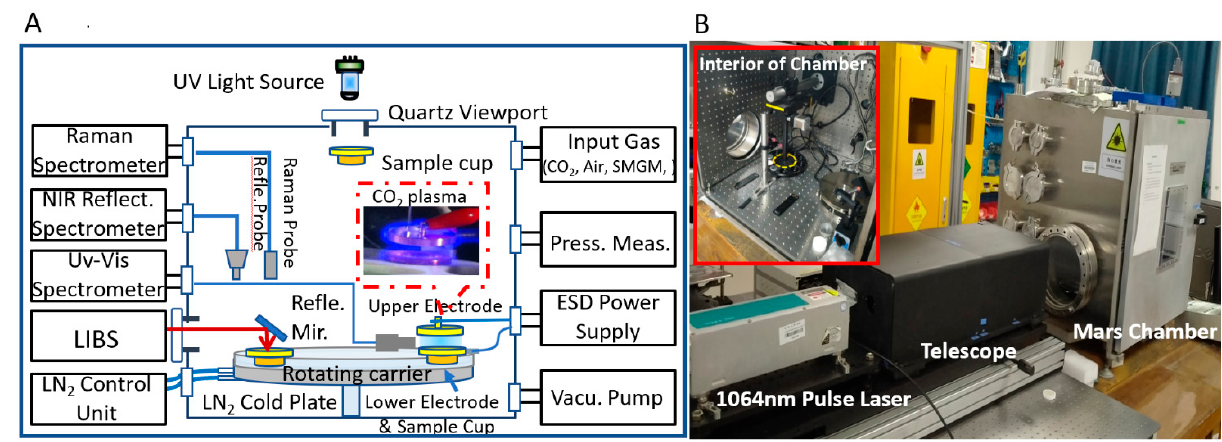
Figure 1. ( A ) Schematic diagram of the Mars chamber and peripheral function units. The inset is a photograph of CO 2 plasma generated between two copper plate electrodes. ( B ) Photograph of the Mars chamber. The upright image is a photograph of the interior of the Mars chamber. The spectral sensor can be used for in situ detection of minerals in chambers or free radicals in CO 2 plasma.